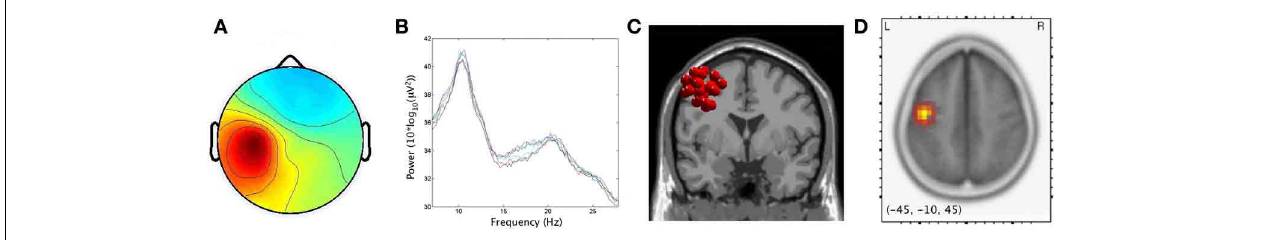
equivalent current dipoles within the cluster, and (D) maximum current source density voxels ( t -values) with greater values in darker colors and smaller values in lighter colors (at p < 0 . 001 corrected for multiple comparisons).